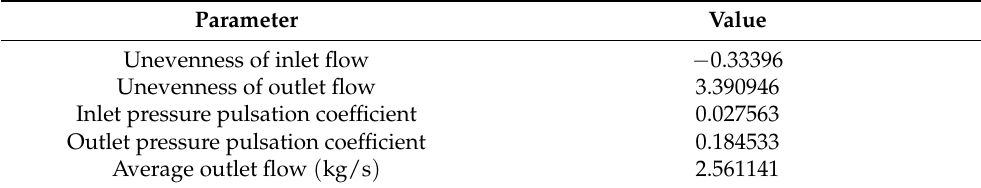
Table 3. Data of the original model.